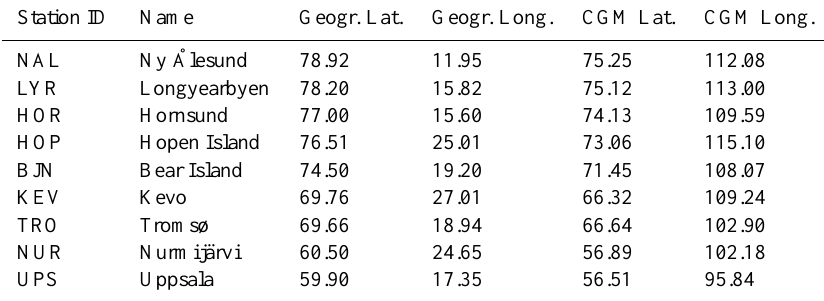
Table 1. Geographical and CGM coordinates of used IMAGE stations.